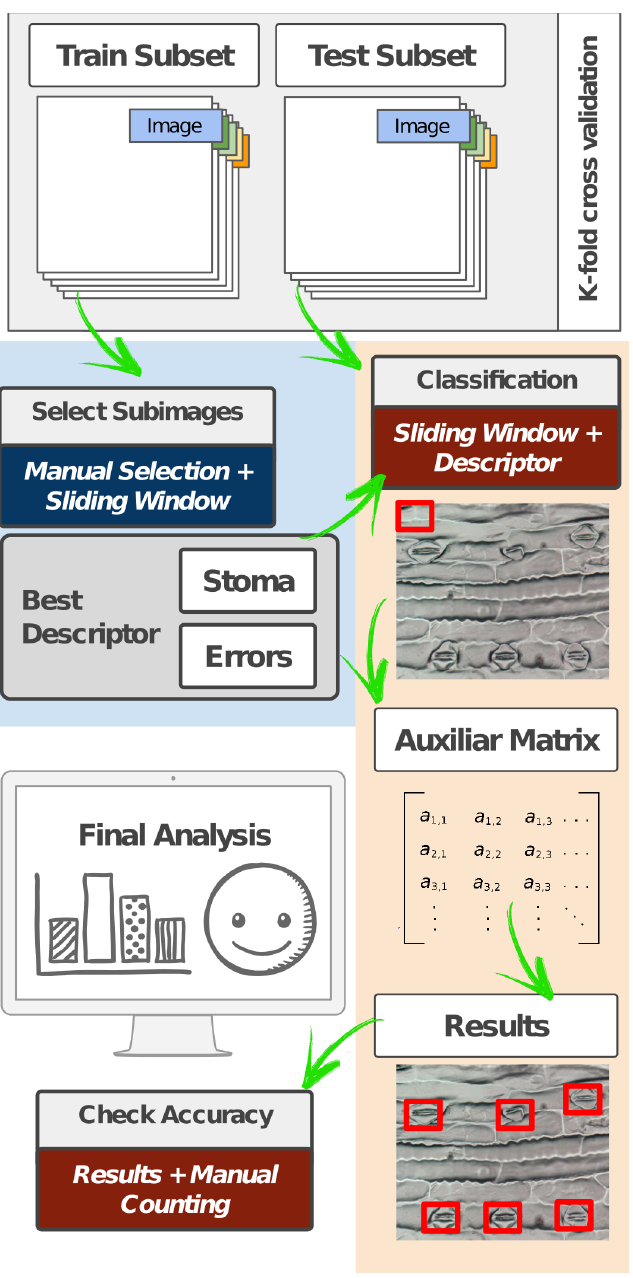
Fig 4. Visual representation of the stoma detection process. From the train and test subsets established according to a k-fold cross validation, a sliding window mechanism was used to go through the image and identify possible regions of pixels corresponding to the